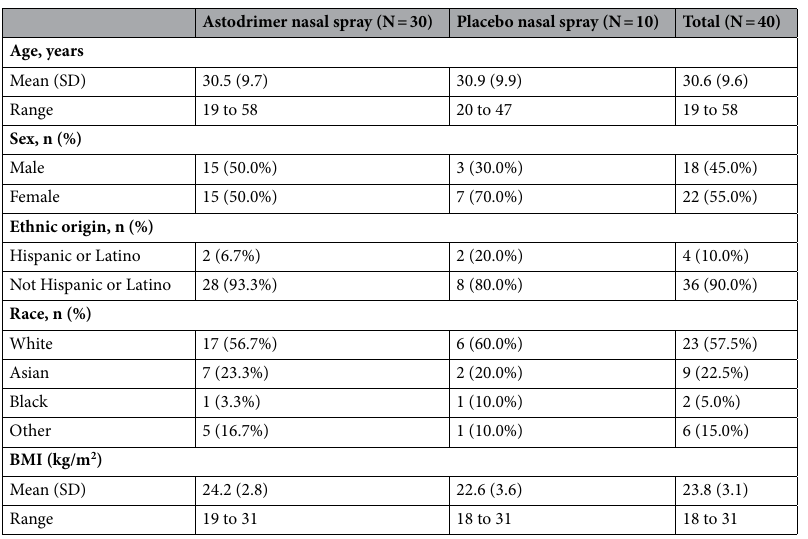
Table 1. Baseline demographic characteristics of the safety population. BMI body-mass index, SD standard deviation.